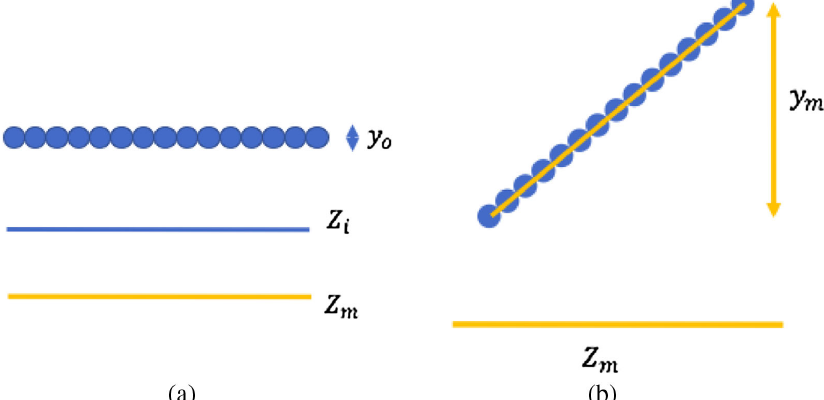
viewer.FIG. 6. (a) Initial longitudinal view of one idealized beamlet after the 1D pepper-pot. y 0 is the transverse size without deflection, Z i is the initial longitudinal bunch length. (b) Longitudinal view of a deflected idealized beamlet and projected size at viewer. y m is the measured transverse projection after deflection, Z m will be the calculated bunch length from the measurement. Visual inspection comparing Z i and Z m shows the true bunch length can be recovered by removing the contribution of the transverse face of the bunch to the projected size.